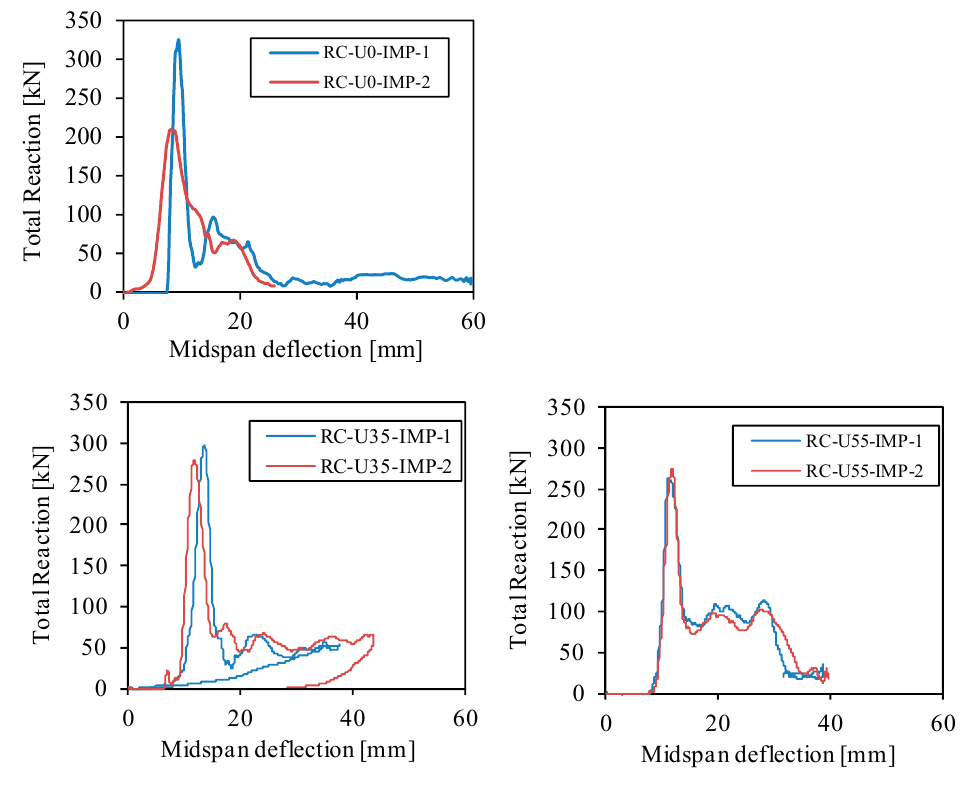
Figure 5. Crack pattern diagrams of tested specimens.